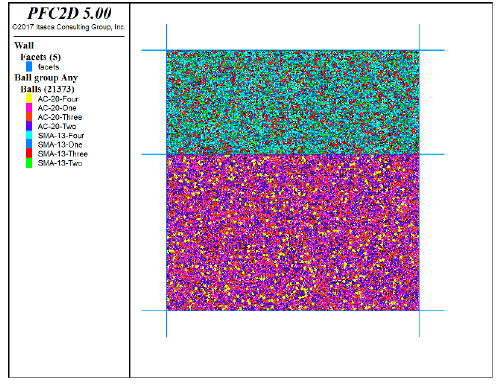
Figure 10. The initial model.